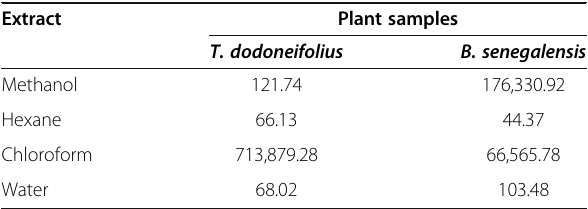
Table 5 IC 50 of T. dodoneifolius and B. senegalensis on human colon cancer cells (HT-29) Extract Plant samples